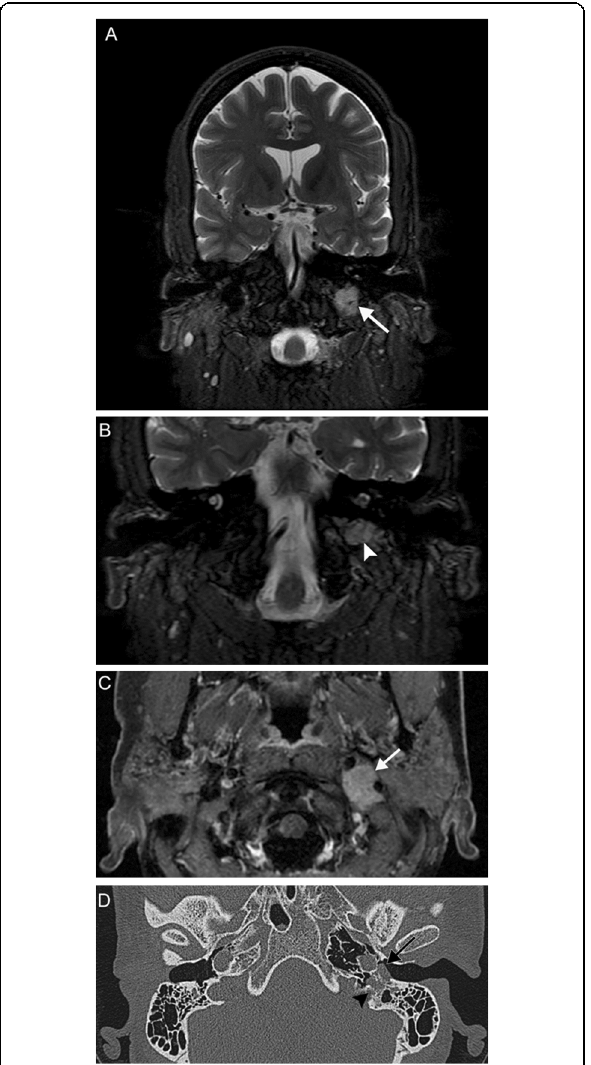
Fig. 12 Jugulotympanicum paraganglioma. A 49-year-old woman with voice change and pulsatile tinnitus. Coronal T2-weighted MR images ( a , b ) and axial contrast-enhanced T1 image ( c ) demonstrate a T2-hyperintense, enhancing mass centered at the left jugular bulb (white arrows) extending into the hypotympanum (white arrowhead). Axial CT of the temporal bones ( d ) reveals abnormal soft tissue in the left middle ear (black arrow) with osseous 'moth- eaten' destruction at the jugular foramen (black arrowhead); the cochlear promontory in preserved (not shown). Based on location and appearance, findings are consistent with a jugulotympanicum